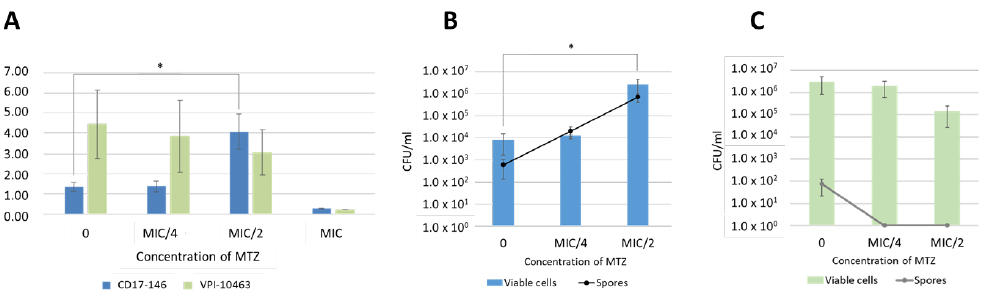
Figure 2. Biofilm quantification of VPI 10463 and CD17-146 at subinhibitory concentrations of MTZ. Bacteria were cultivated in BHI-SG broth without or with MTZ at MIC/4 and MIC/2 at 37 °C under anaerobic conditions to form biofilms. After 48 h, the biofilm mass was quantified by crystal violet staining. A 4-fold increase of biomass was observed in the CD17-146 strain at MIC/2 ( A ). Panels ( B ) and ( C ) depicts enumeration of vegetative forms and spores included in biofilms formed the two strains CD17-146 and VPI 10463, respectively. Data are means of at least three independent experiments, each performed in triplicate. The error bars represent standard deviation. Significantly different ( p < 0.05) ratios are indicated by asterisks (Man-Whitney test).